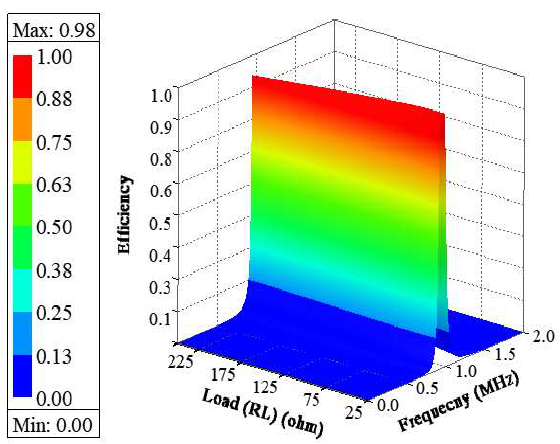
Figure 7. Three-dimensional representation of relation between frequency, load, and efficiency.